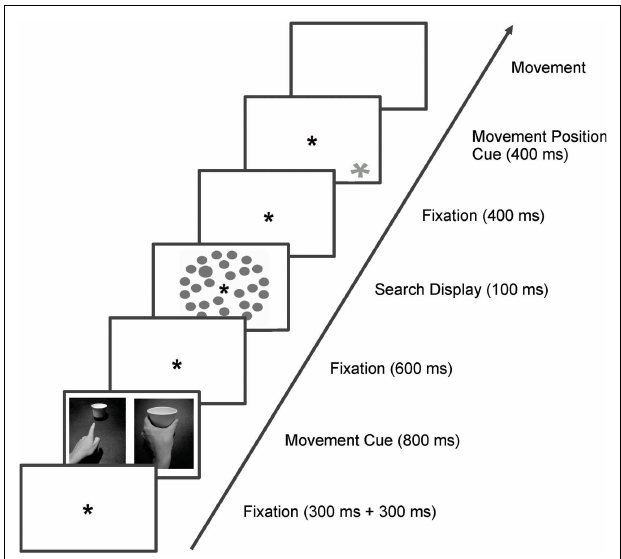
FIGURE 1 |Trial sequence of Experiment 1 and 2. Trials started with a fixation mark (in Experiment 1 it was the continuous valid pupil signal of 300 + 300ms), followed by one of the cues (pointing/grasping; 800ms), which informed participants which movement they should prepare. After another fixation mark (600ms), the search display (target/no target) appeared on the screen (100ms), and was followed by another fixation mark. Four hundred milliseconds after response to the search task, the movement position cue (400ms) appeared and participants performed the prepared movement on the respective paper